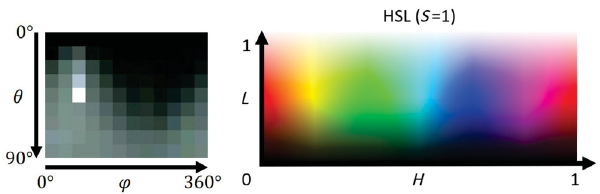
Left: visualization of reflectance behavior for one pixel for full angular spectrum (light source elevation θ and rotation angle ϕ ). Right: HSL color spectrum.